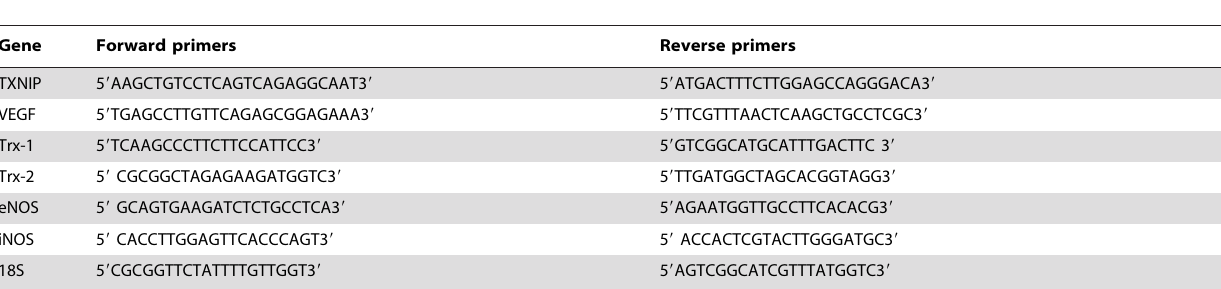
Table 1. Primer sequence used to quantify mRNA expression levels using PCR analysis.